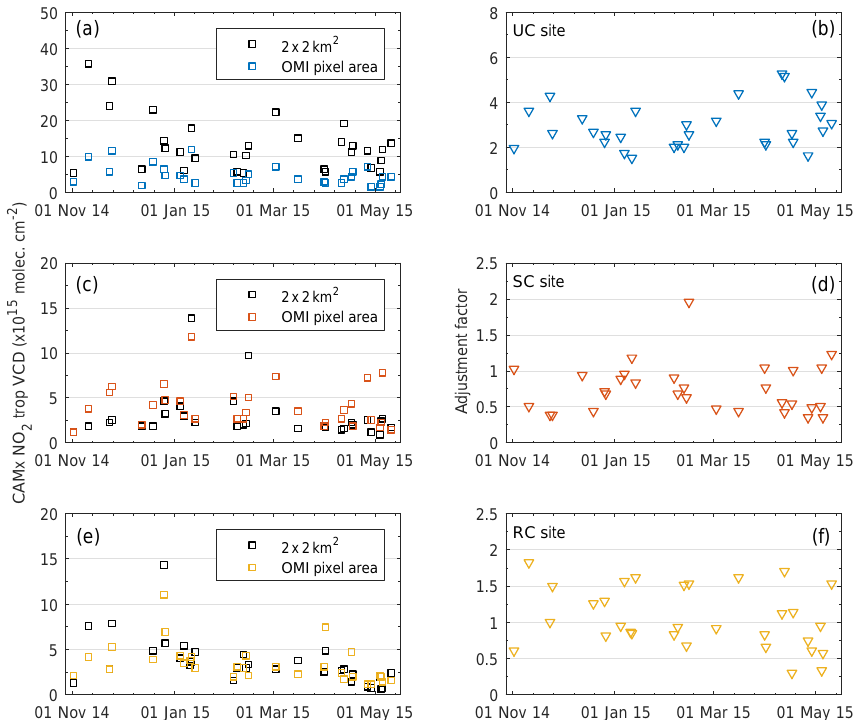
Figure 9. Hourly NO 2 tropospheric VCDs (a, c, e) and the corresponding adjustment factors (b, d, f) calculated by means of CAMx air quality simulations for the UC site (a, b) , the SC site (c, d) and the RC site (e, f ). (b, d, f) Only the NO 2 columns from CAMx corresponding to OMI overpass data are presented here. The black squares correspond to data for the CAMx cells, which include the monitoring sites, and the colored squares to data averaged over the close-to-actual OMI pixel area.